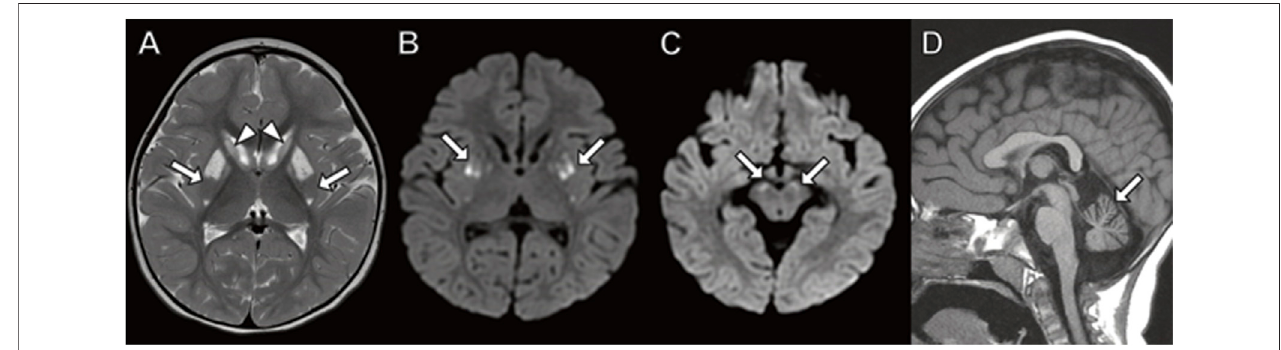
FIGURE 3 | Brain MRI in 22-month-old girl with SERAC1 mutation. (A) Axial T2 image demonstrates abnormal signal throughout the basal ganglia with sparing of the dorsal putamen (arrow) resulting in a fi nding described as the “ putaminal eye ” . There is abnormal signal and atrophy of the caudate heads (arrowheads) and globus pallidus. (B,C) Axial diffusion-weighted images with restricted diffusion in the putamen ( (B) arrows) and substantia nigra ( (C) arrows). (D) Prominent cerebellar folia indicating cerebellar atrophy (arrow) is present on sagittal T1-weighted